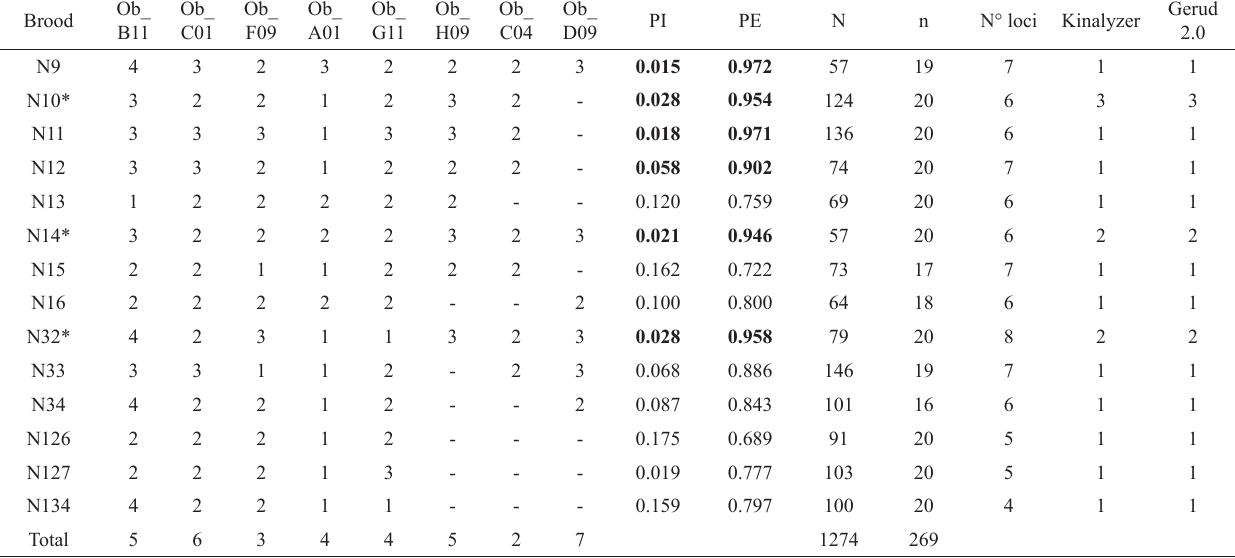
Table 1. Number of alleles per loci, per brood. *Non-monogamous broods. PI = Probability of Identity. PE = Probability of Exclusion. N = Number of fry per brood. n = number of fry analyzed per brood. N° loci = Number of microsatellite loci used per brood. The number of sibling groups estimated with the use of the softwares Gerud 2.0 and Kinalyzer. PI and PE indicate that the number of loci is very informative to six of the fourteen broods (in